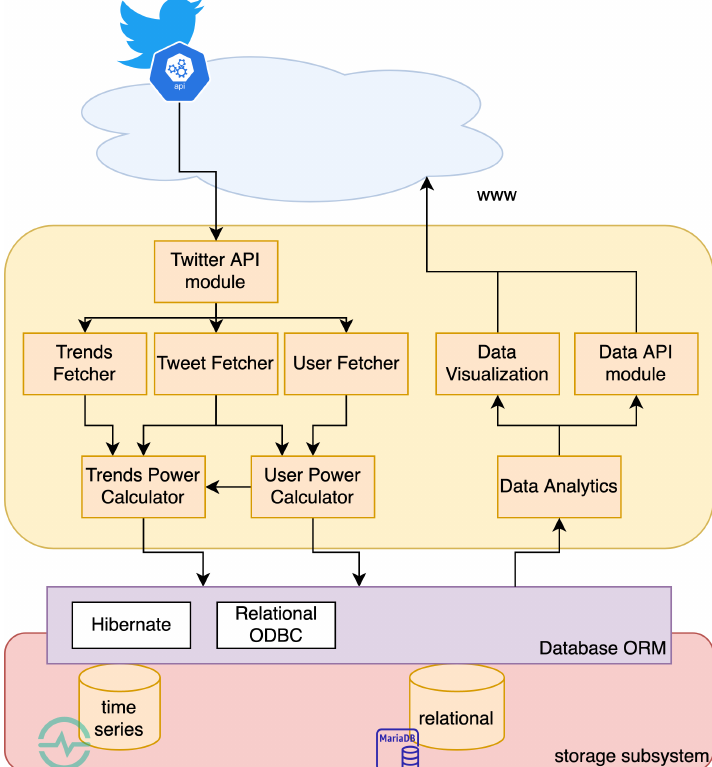
Figure 1. System